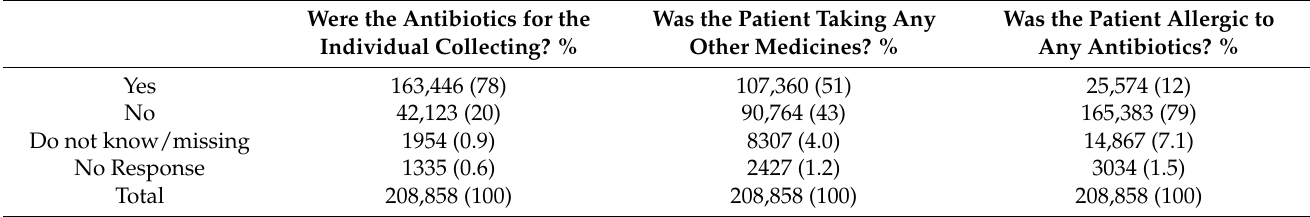
Table 1. Findings from Patient response section of the Antibiotic Checklist.